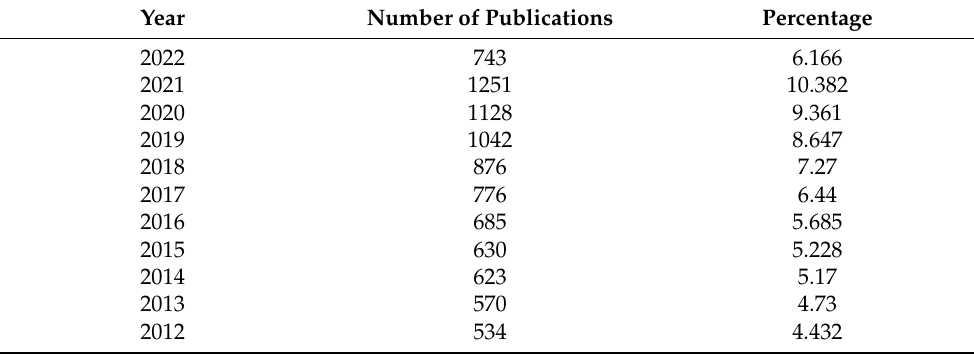
Table 3. Number of publications on BIM technology.